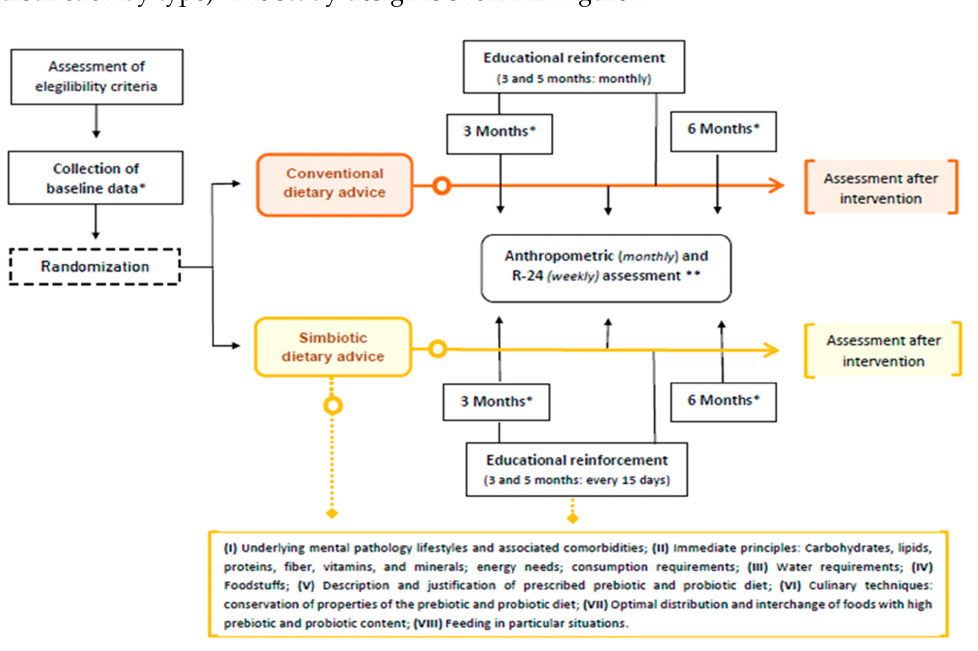
Figure 1. Study Design. * Data collected at baseline and six months of intervention: (1) Nutritional profile. ** Data collected at baseline and monthly during the intervention: (1) Anthropometric data (weight, height, Body Mass Index—BMI, waist circumference and waist-to-height ratio—WHtR-); (2) R-24 (weekly determination of foods with high symbiotic content in adherence to established dietary plan).